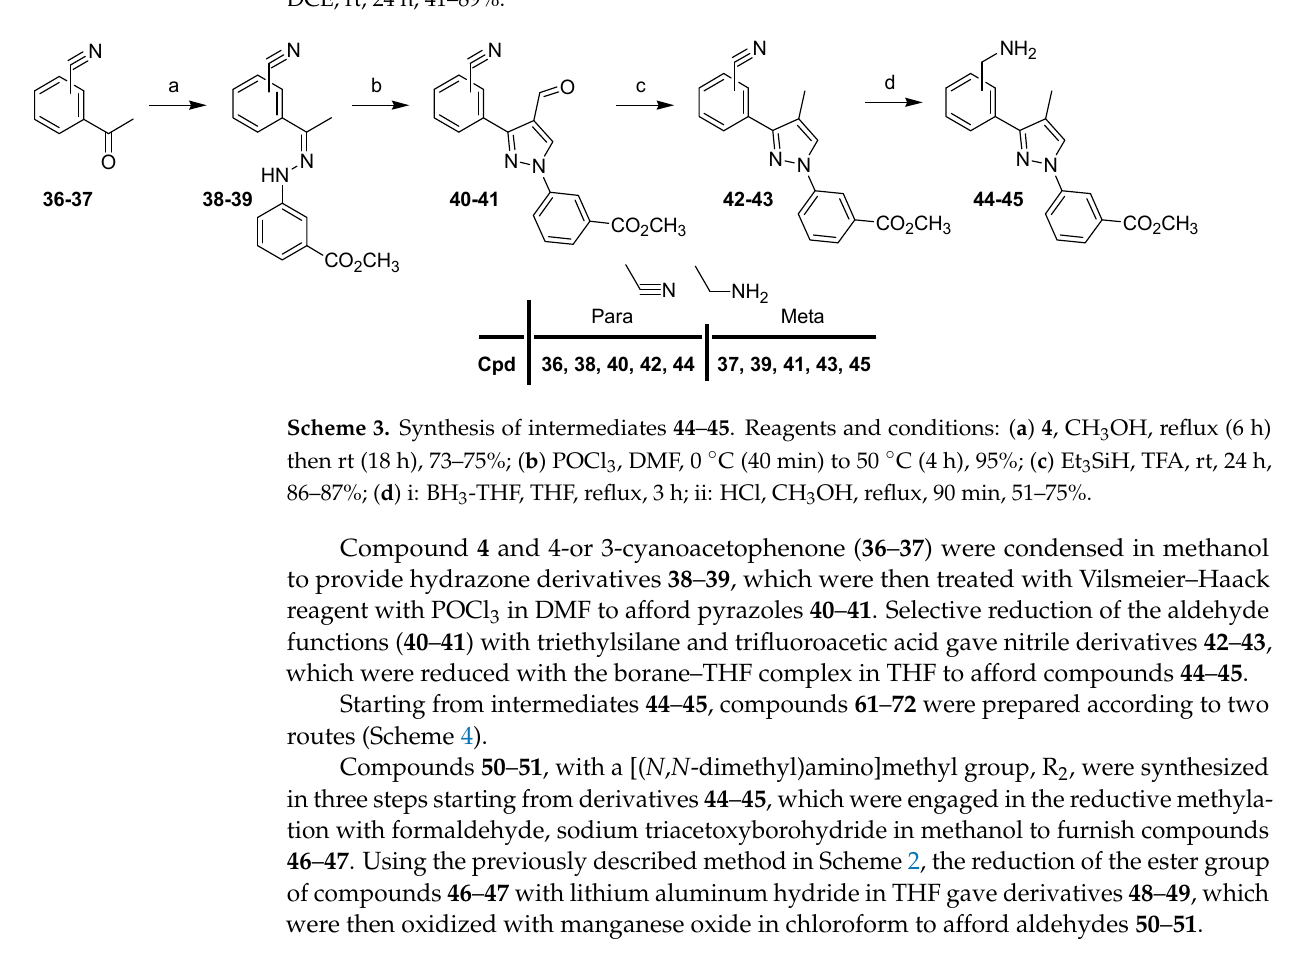
Scheme 2. Synthesis of compounds 24 – 35 . Reagents and conditions: ( a ) LiAlH 4 , THF, 0 °C (20